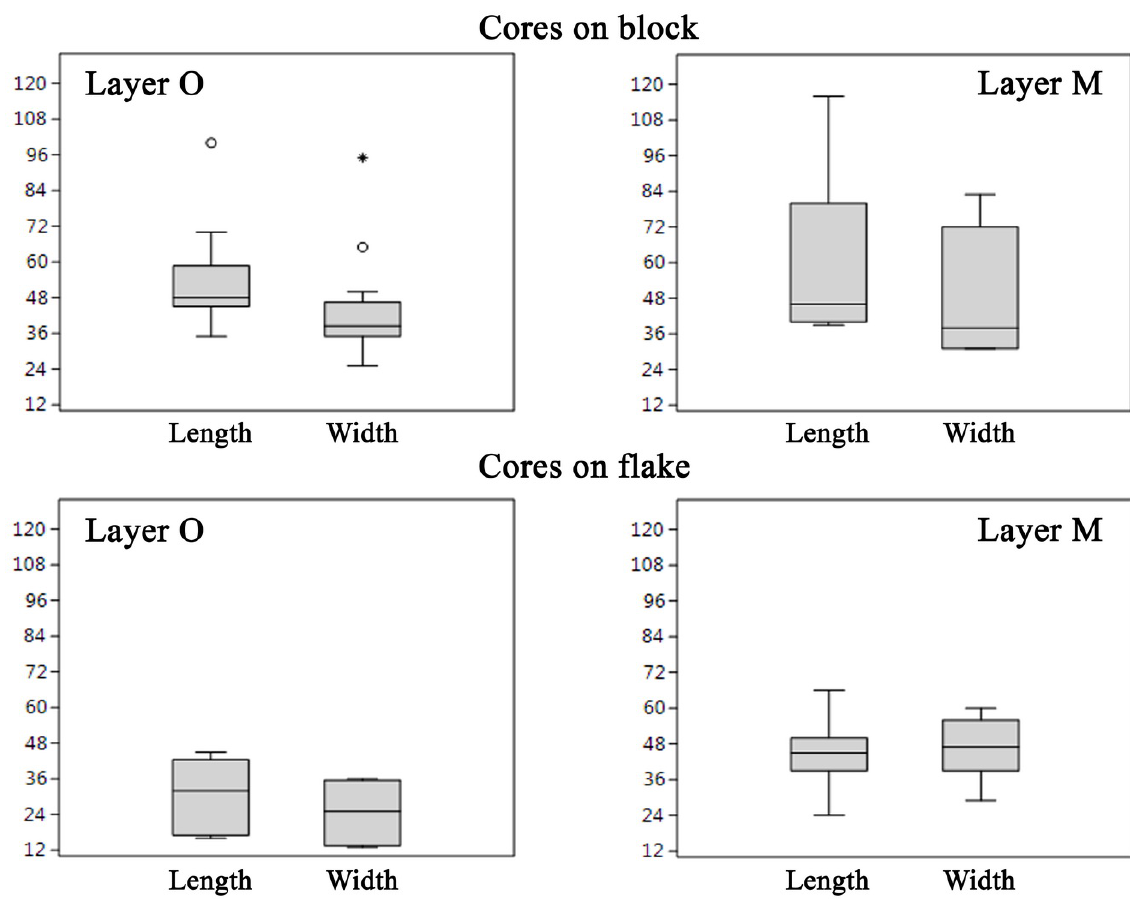
Figure 5. Length and width of cores. Dimensions are in